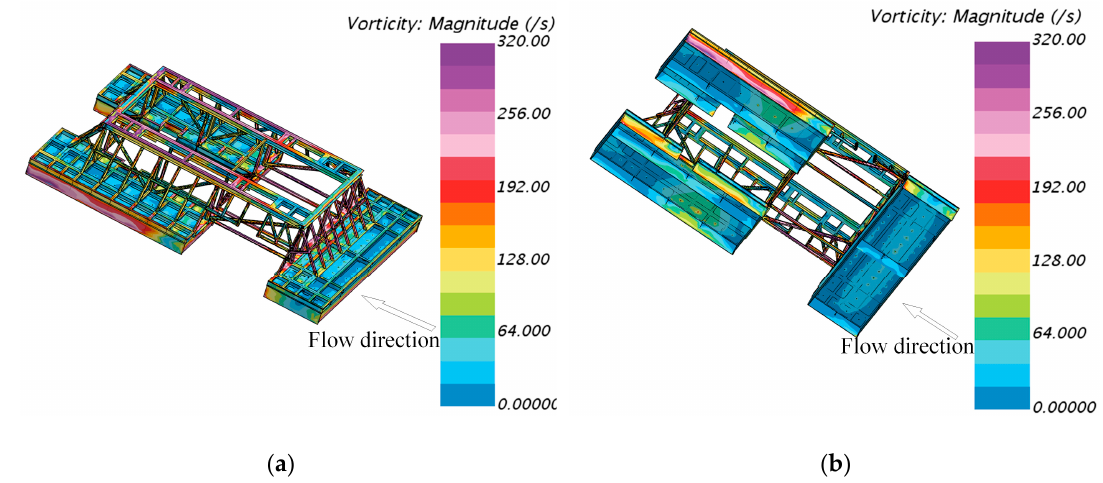
Figure 15. Vorticity visualization on the surface of the model in Case 10: ( a ) Top view of the flow field, ( b ) Bottom view of the flow field.